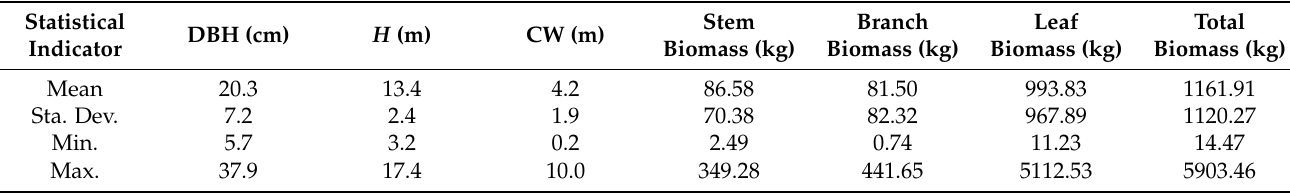
Table 1. The basic information of Simao pines in the plot.